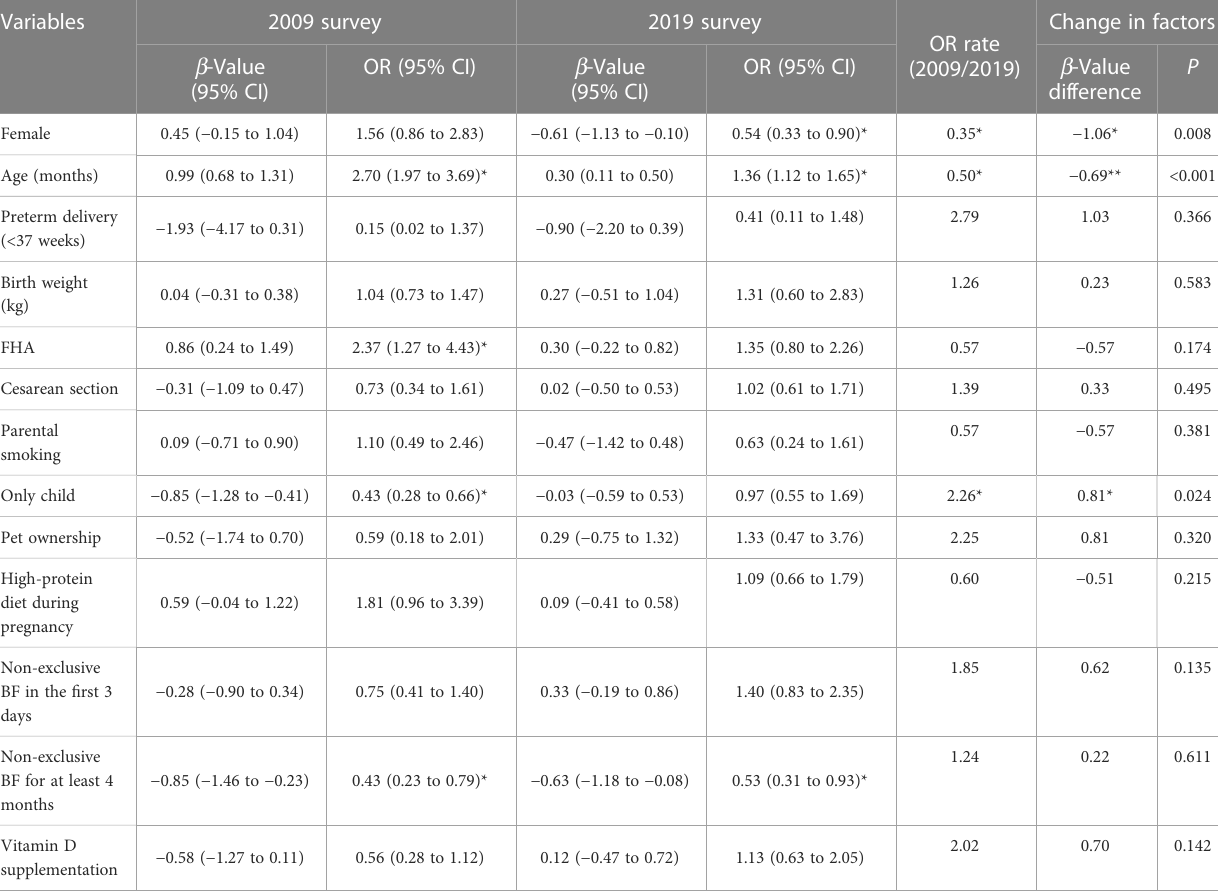
TABLE 3 A comparison of the change in food sensitization risk factors between the 2009 and 2019